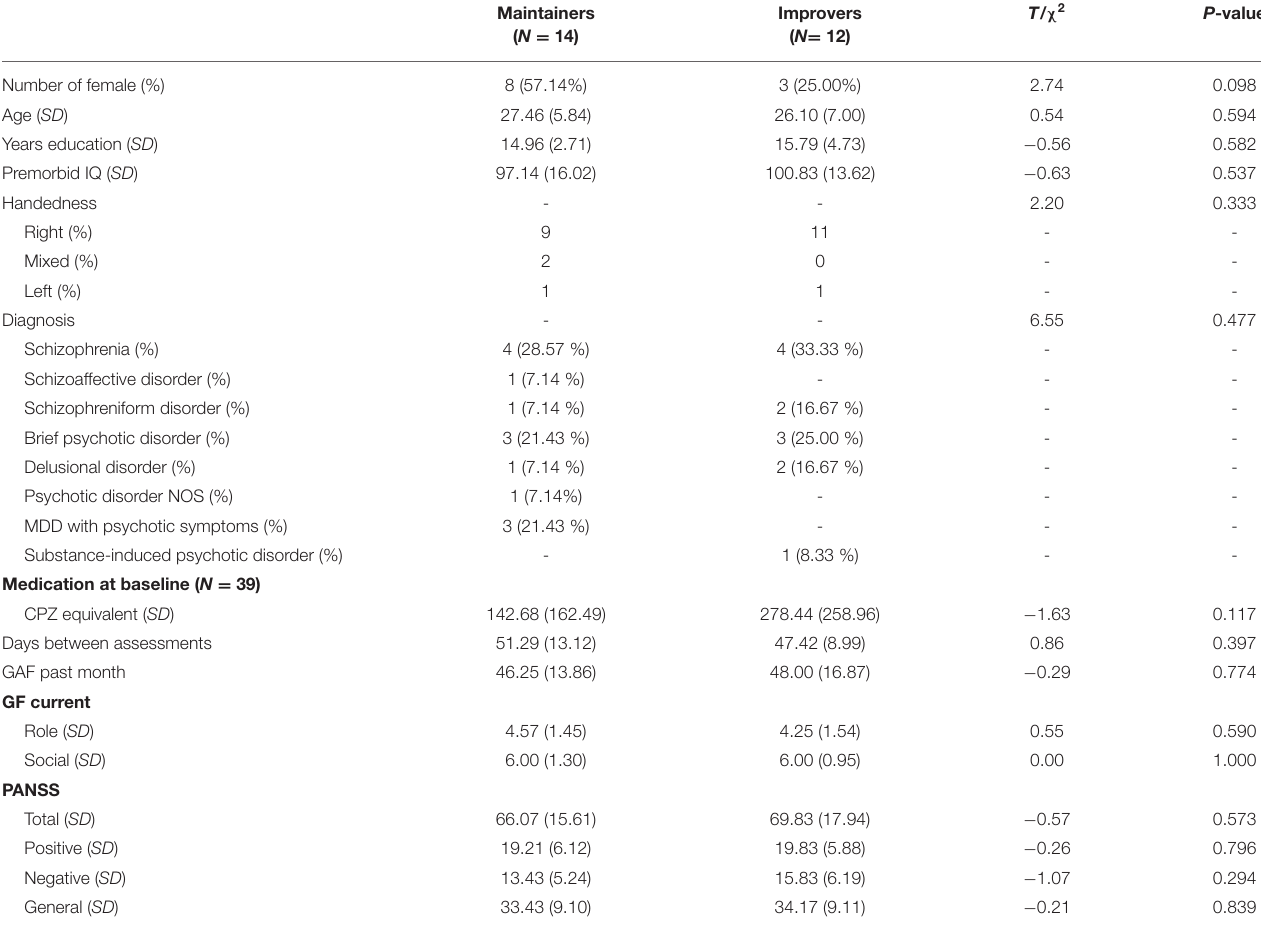
TABLE 1 | Baseline demographic information of the intervention CCT